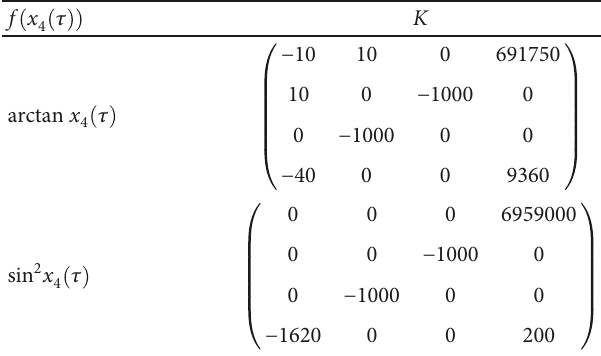
Figure 3: The chaotic attractors of system (3) with f x x 4 τ . Table 1: The feedback gain matrix derived by Proposition